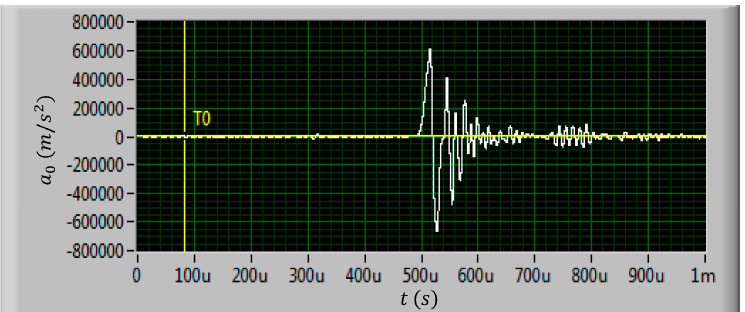
Figure 10. The measured 60,000 g shock load waveform.